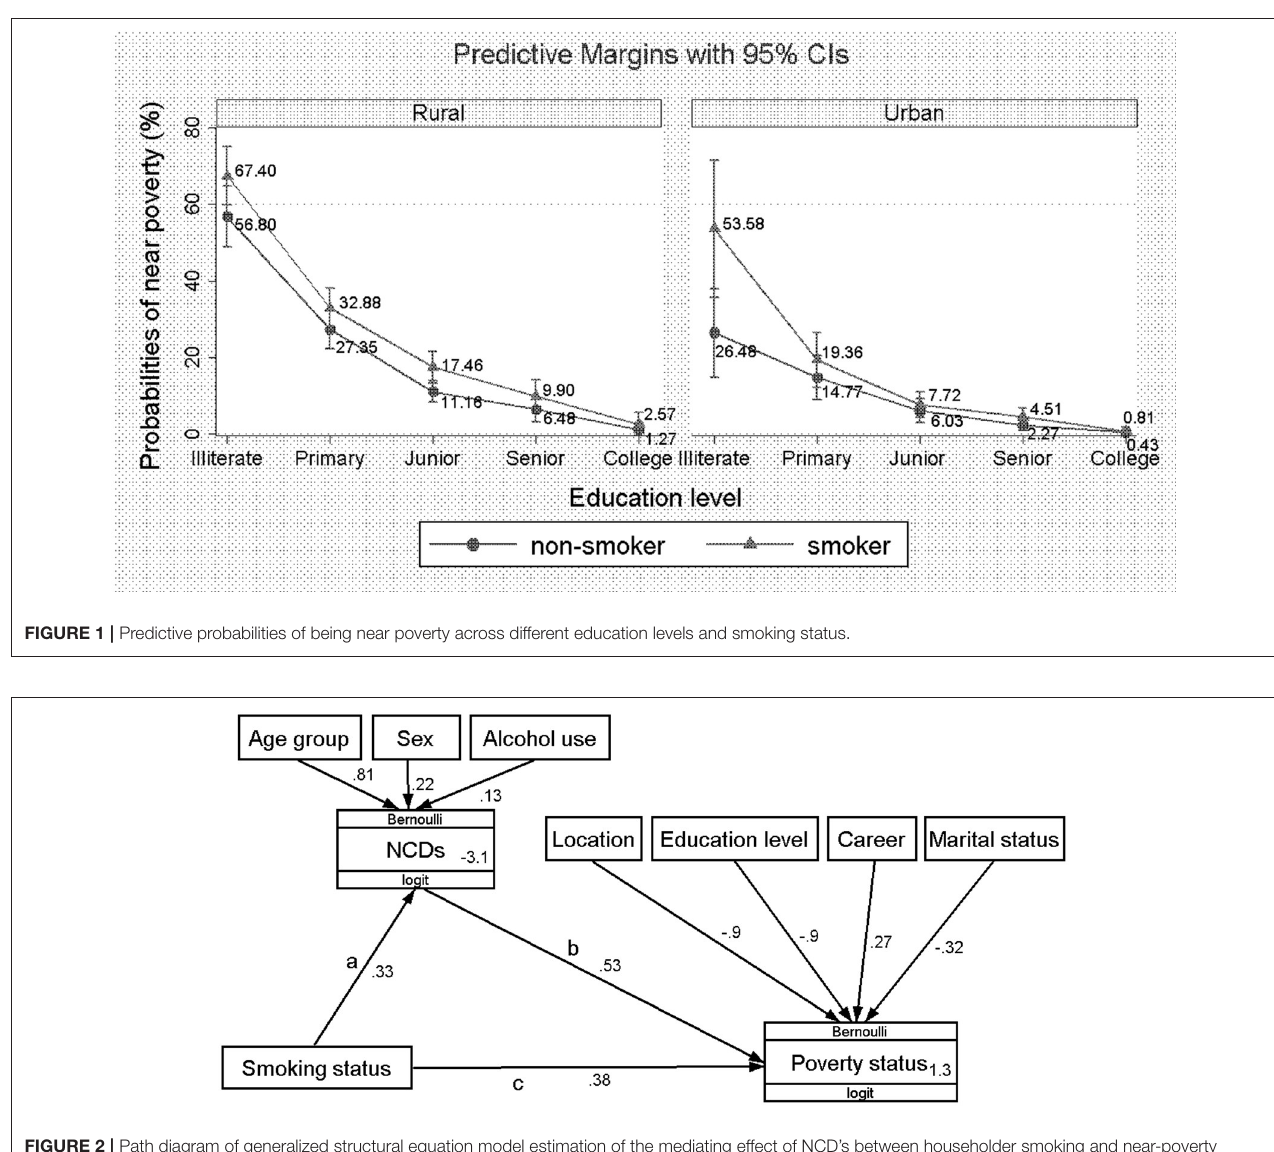
FIGURE 2 | Path diagram of generalized structural equation model estimation of the mediating effect of NCD’s between householder smoking and near-poverty status. Path c is the direct effect before taking into account the effect of NCDs. Path a and b make up the mediating pathway, with the mediating effect usually being described in the literature as the product of co-efficient (ab). Age group, sex, and alcohol use were adjusted as confounding variables of NCDs. Residence location, education level, career, and marital status were adjusted as the confounding variables of being near